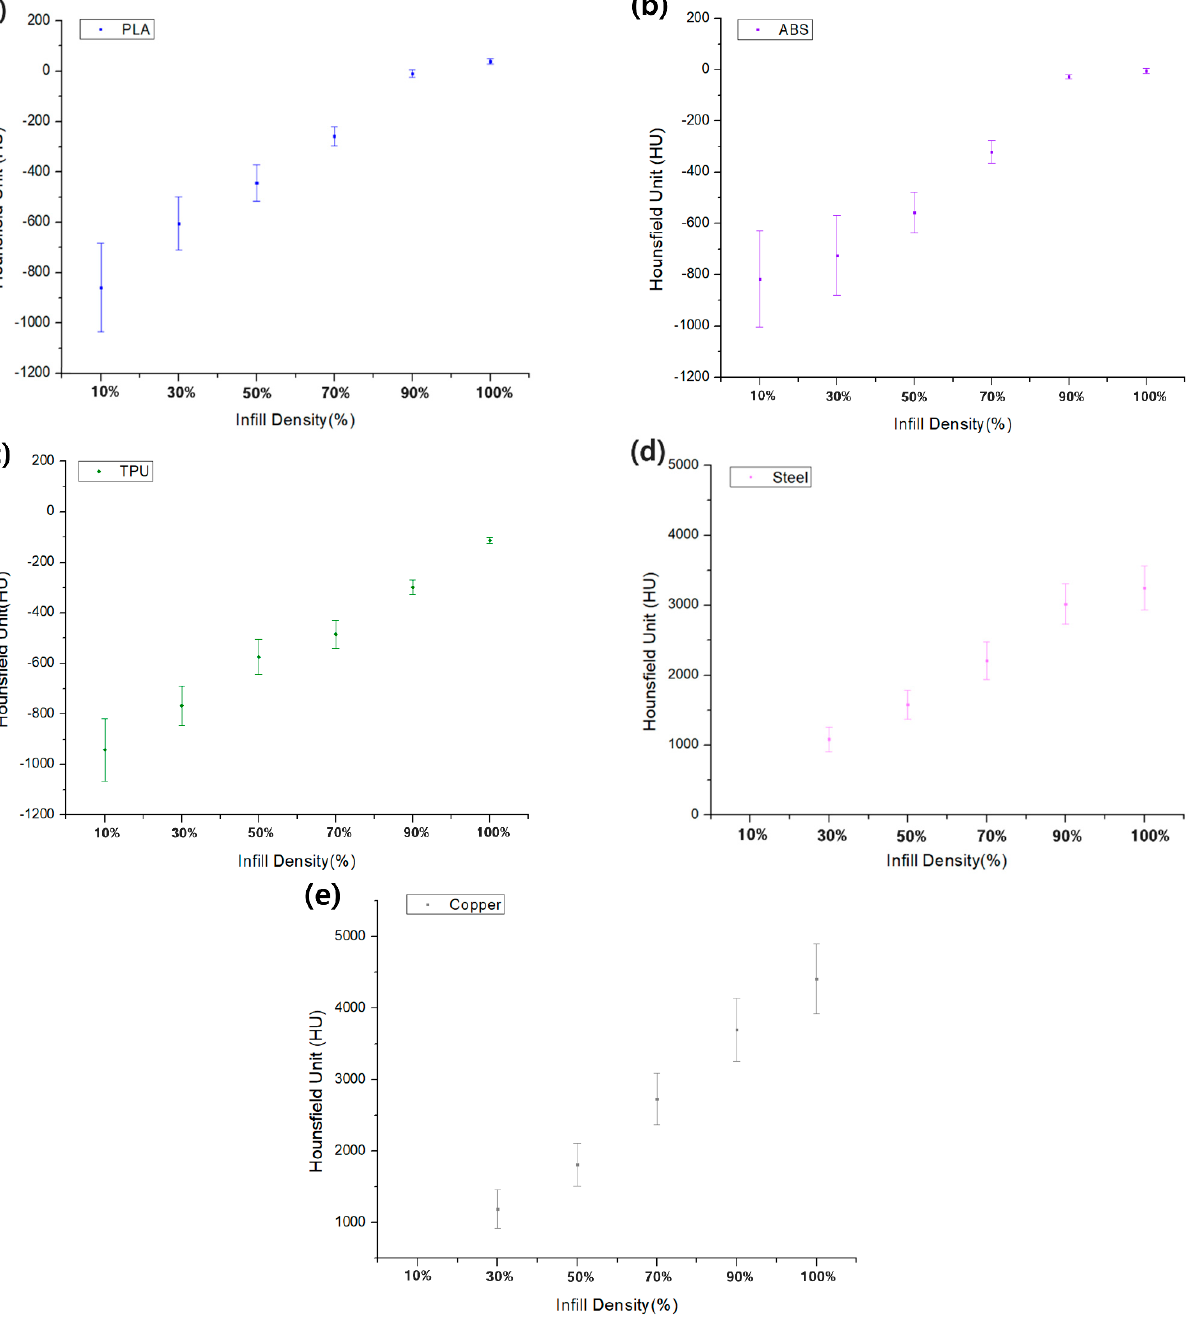
Figure 4. Comparison of Filament HU Values and Infill Density: ( a ) PLA, ( b ) ABS, ( c ) TPU, ( d ) Steel, ( e ) Copper.